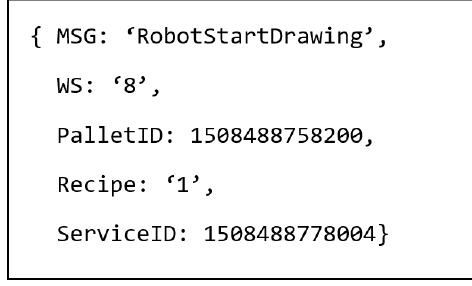
Figure 7. Event notification received form the FASTory Simulator.